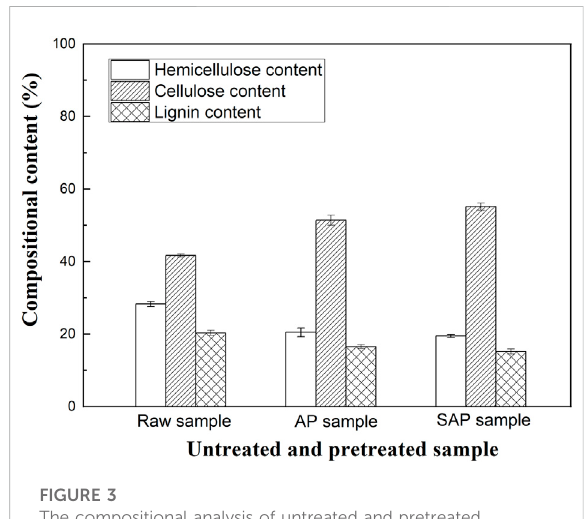
FIGURE 2 The effect of SAP with PEG surfactants on enzymatic hydrolysis.